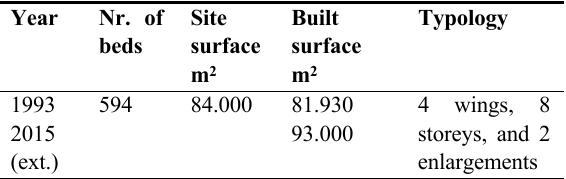
Table 1. General specifications for the University Hospital Príncipe de Asturias.